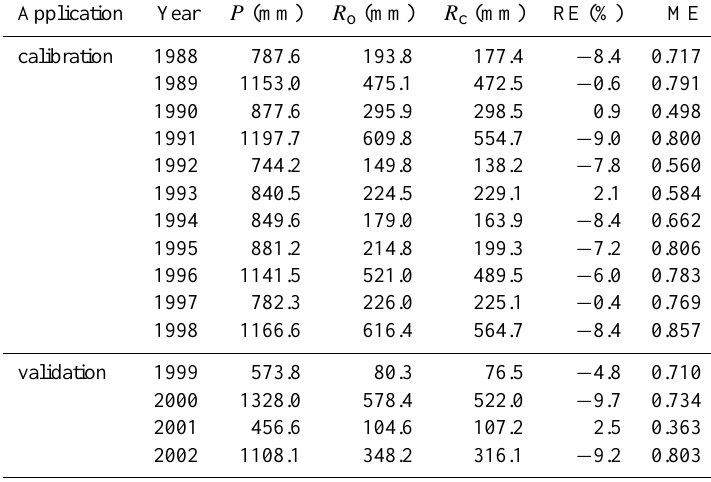
Table 3. Daily simulation performance of the Xin’anjiang Model during 1988–2005.